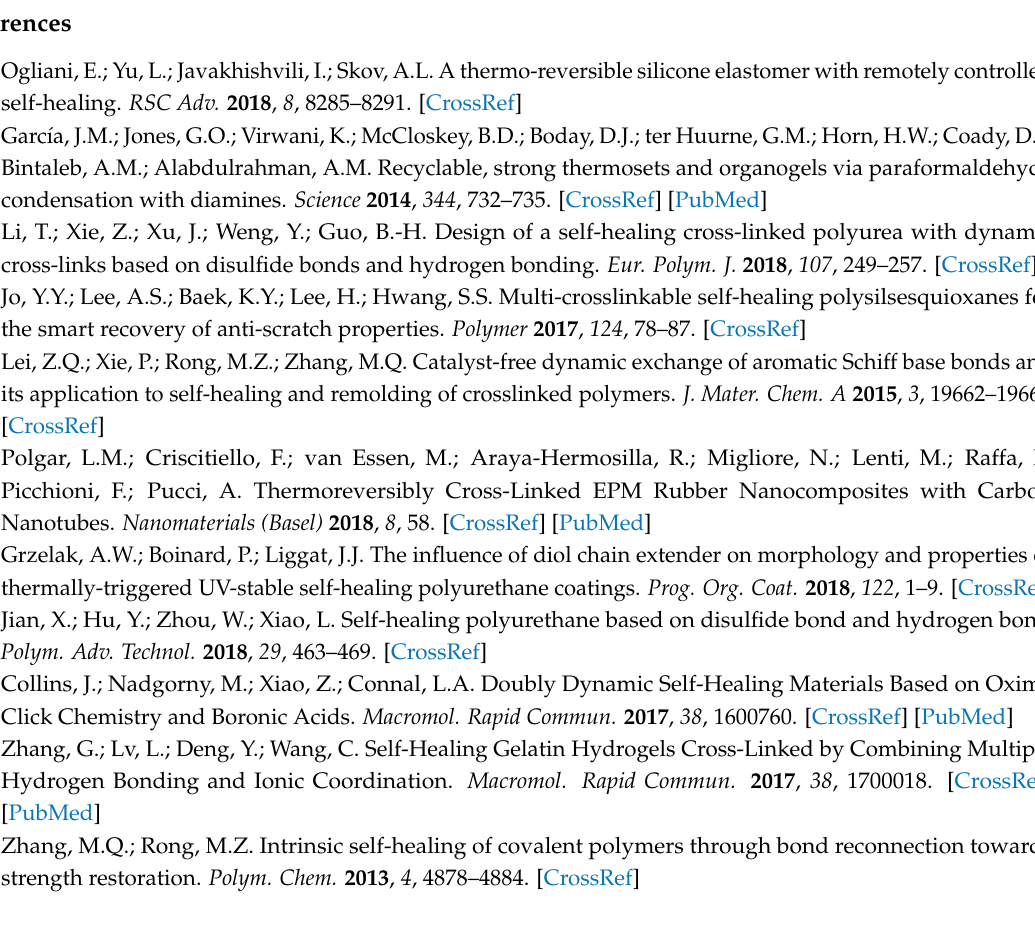
Figure S1: FT-IR spectra of WPU during the chain extension, Figure S2: Images of WPU emulsions, Figure S3: Particle size distribution of WPU emulsion, Figure S4: 1 H NMR spectra of the model compounds for the exchange reaction Urea-1 and Urethane: (a) butanol; (b) Urethane; (c) products of the exchange reactions between Urea-1 and Urethane, Figure S5: 1 H NMR spectra of the model compounds for the exchange reaction Urea-1 and Urea-2: (a) octyl amine; (b) Urea-2; (c) products of the exchange reactions between Urea-1 and Urea-2, Figure S6: The FT-IR spectra of PU films before and after heat treatment for 24 h at 110 ◦ C, Figure S7: The FT-IR spectra of PU films before and after heat treatment for 24 h at 110 ◦ C in the wavenumber of 2000~1000 cm − 1 , Figure S8: SAXS data of WPU films before and after heat treatment for 24 h at 110 ◦ C, Figure S9: SAXS data of WPU films before and after heat treatment for 24 h at 110 ◦ C in each sample, Figure S10: SEM images of the WPU films after the second self-healing test by the additional scratch and heat treatments at 110 ◦ C for, Table S1: Number average particle size of WPU emulsions, Table S2: Gel contents of WPU films, Table S3: d-spacing of WPU films based on SAXS